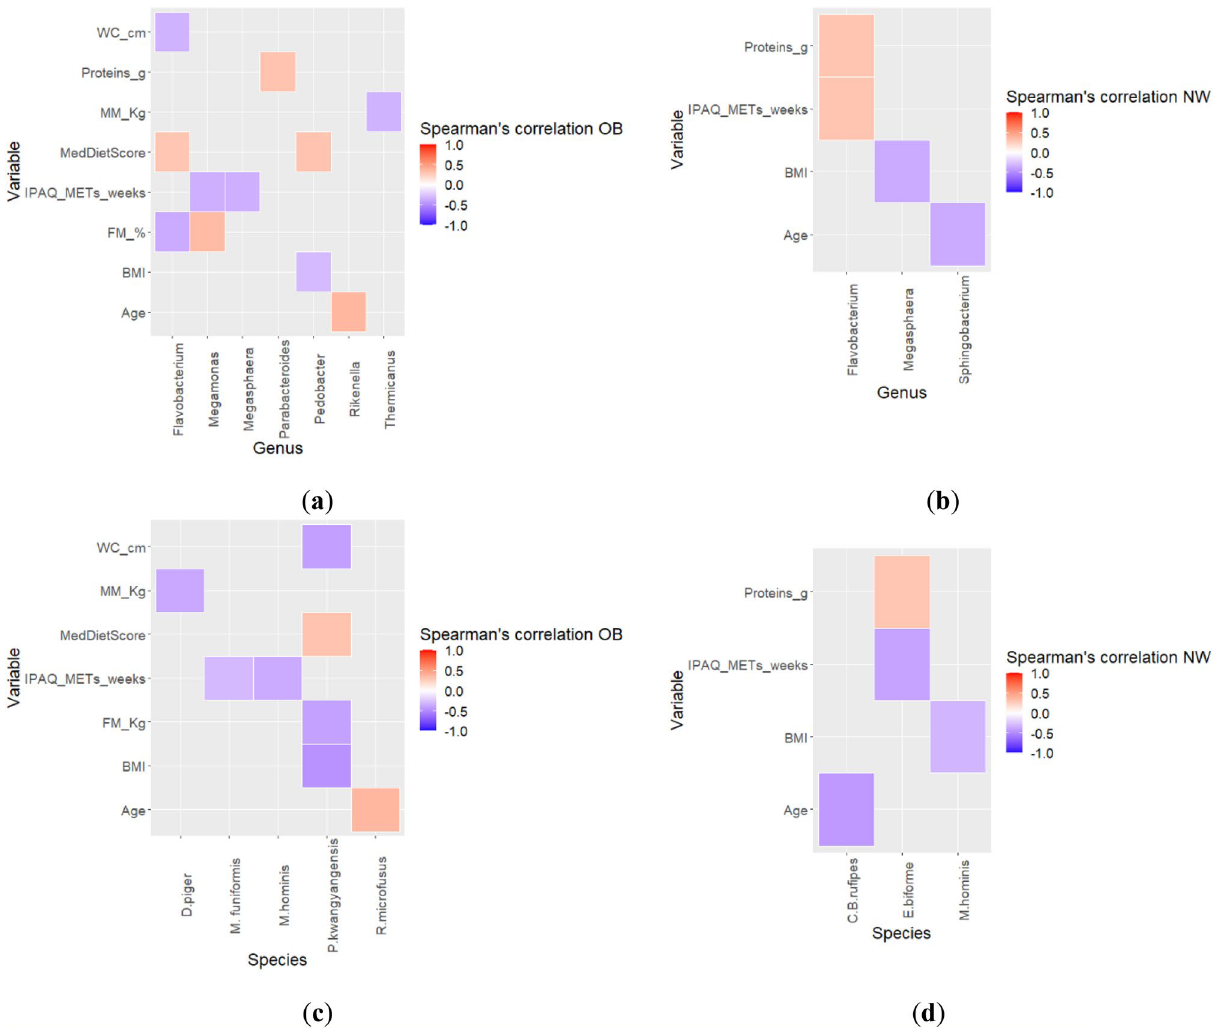
Figure 5. Spearman correlation analysis between GM alterations and clinical variables in OB and NW. Heatmaps were generated in R software v.3.5.2 (ggplot2 package). The correlation heatmap is used to represent significant statistical correlation values (Rho) between gut microbiota genera and species significant at the multivariate analysis and clinical features. In heatmap, red squares indicate significant positive correlations (Rho > 0.5, p < 0.05) and blue squares indicate significant negative correlations (Rho < − 0.5, p < 0.05). Only p < 0.05 are